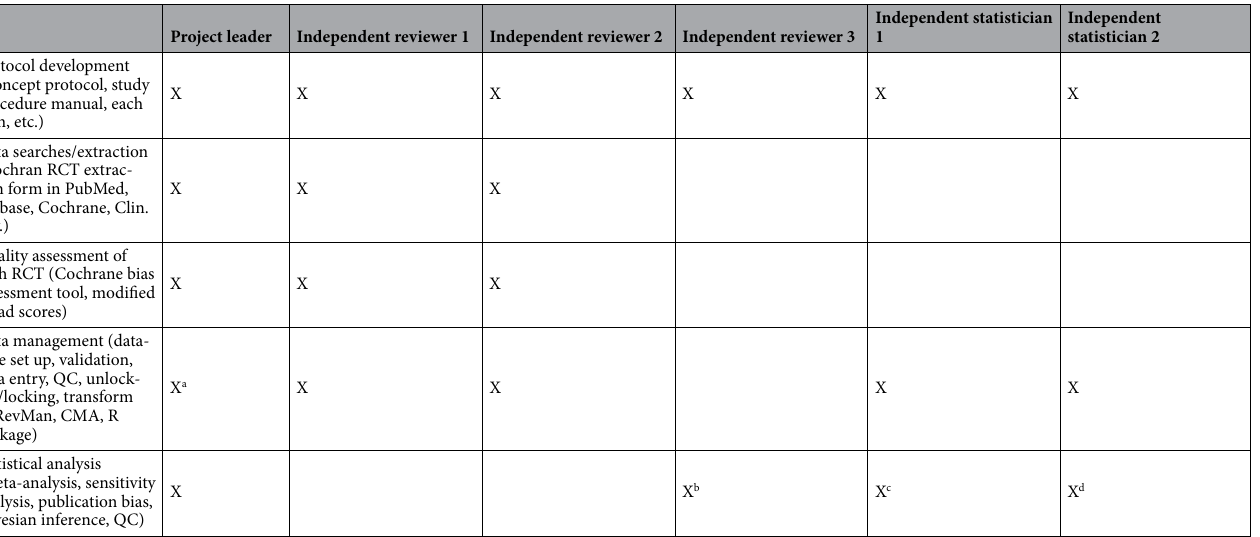
Table 1. Functional responsibilities for the systematic review and meta-analysis. RCT randomized controlled trial, QC quality control, SA statistical analysis, RevMan Review Manager, CMA Comprehensive Meta- Analysis. a Confirmed after data locking. b Performed Bayesian inference. c Performed meta-analysis, sensitivity analysis, publication bias, Bayesian inference, QC. d Performed meta-analysis, sensitivity analysis, publication bias, QC.